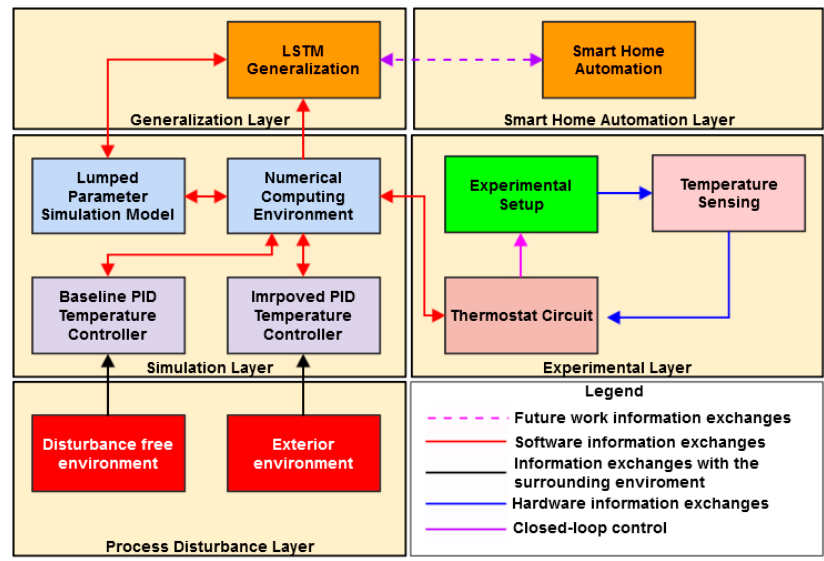
Figure 5. The proposed approach and its layers of abstraction.